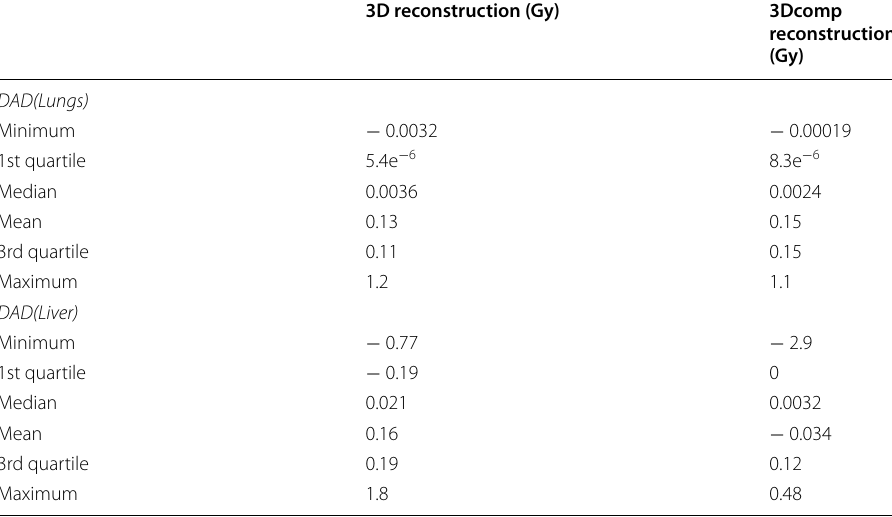
For each, the minimum, 1st quartile, median, mean, 3rd quartile and maximum DAD are given